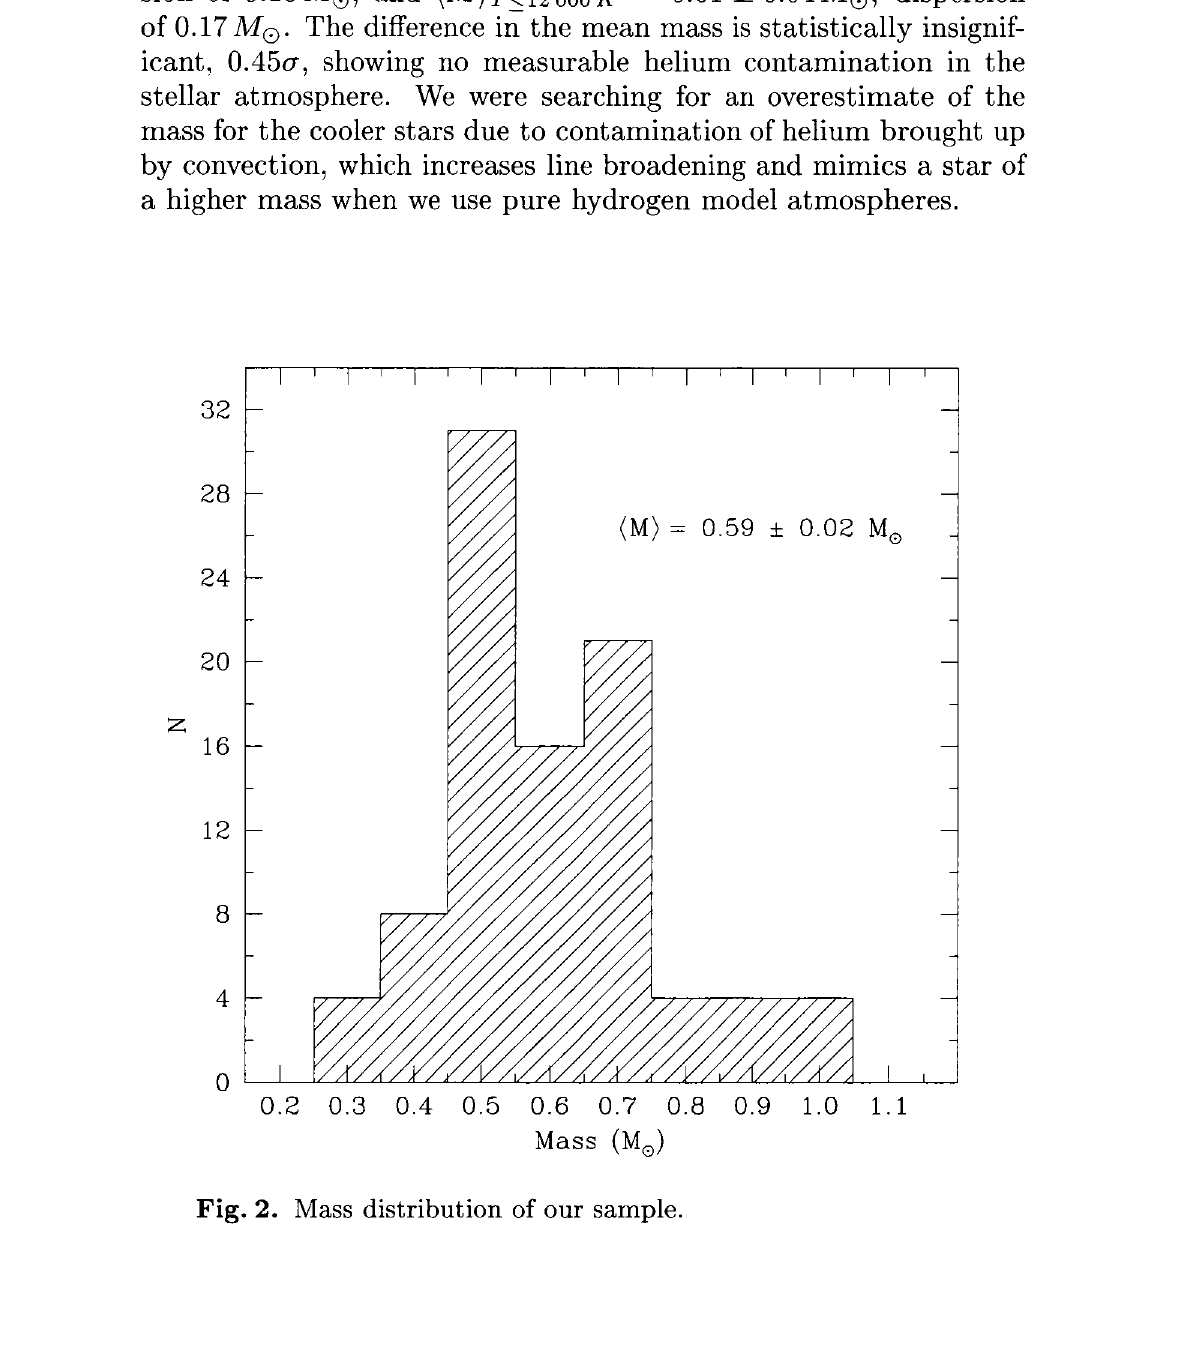
Fig. 2. Mass distribution of our